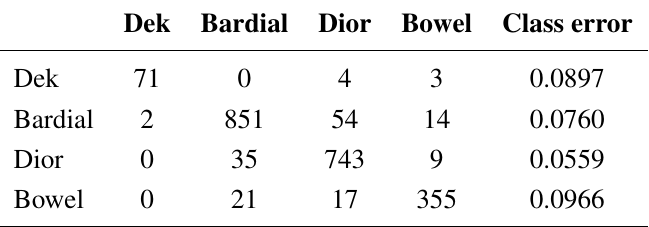
Table A3. This confusion matrix of the Random Forest model shows which pixels are correctly classified for each class. OOB (out-of-bag) estimate of error rate is 7.3% and attests a high model accuracy.